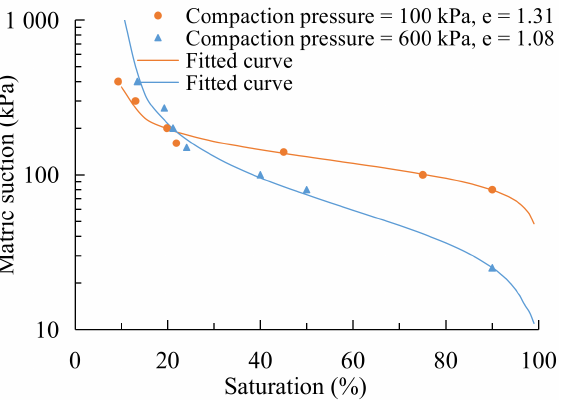
Figure 18. Soil–water characteristic curve of the experimental points and fitted curve at different compaction pressures.